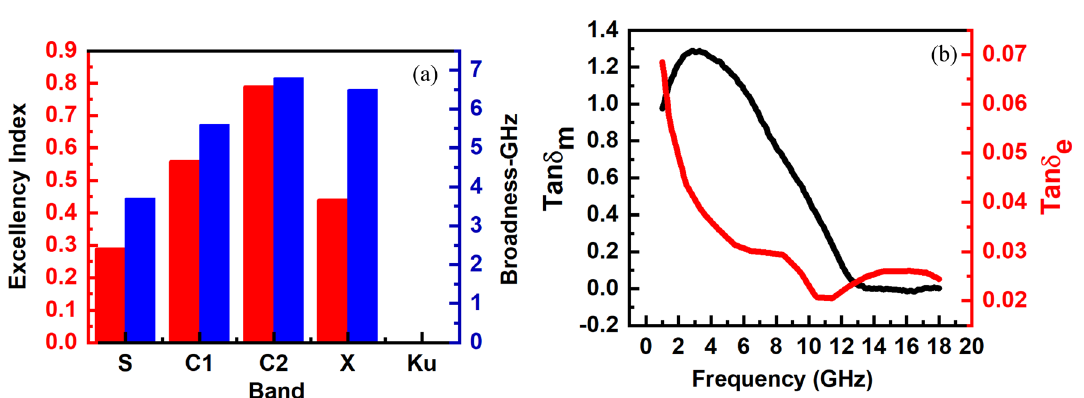
Figure 10. ( a ) PI index for various bands and ( b ) dielectric and magnetic loss versus